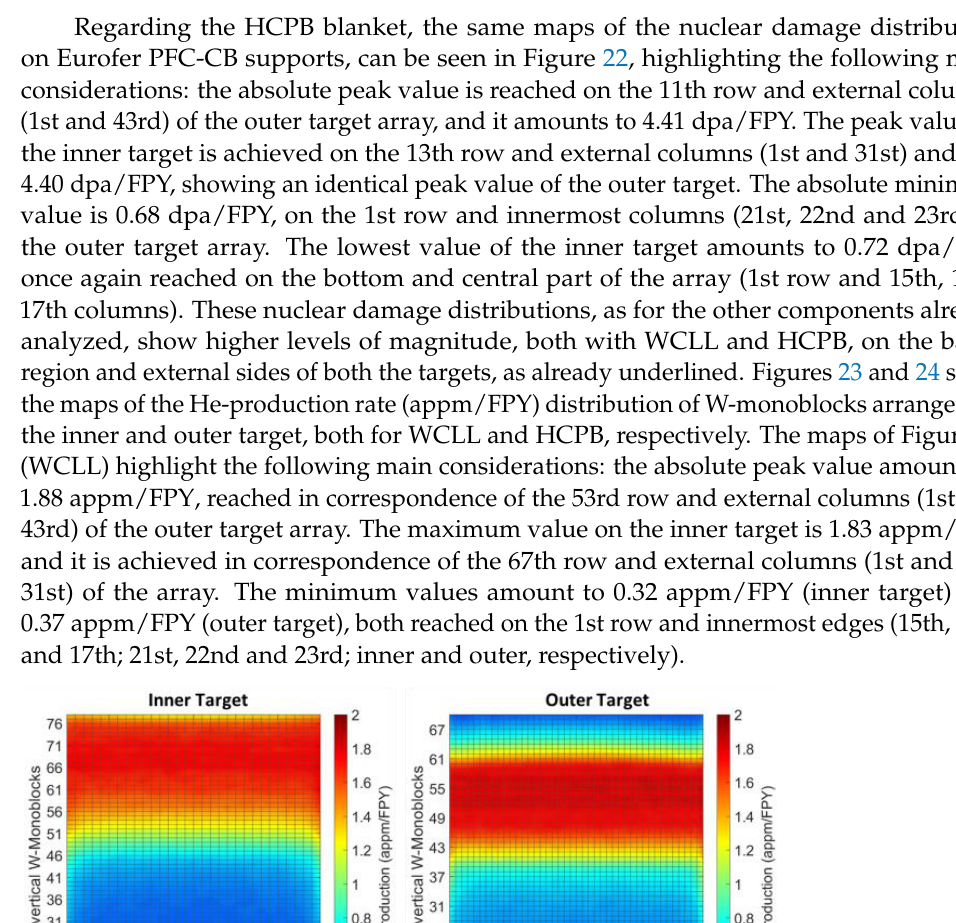
Figure 22. Nuclear damage (dpa/FPY) distribution on PFC-CB supports (Eurofer) of the inner ( left ) and outer ( right ) target, with HCPB blanket.